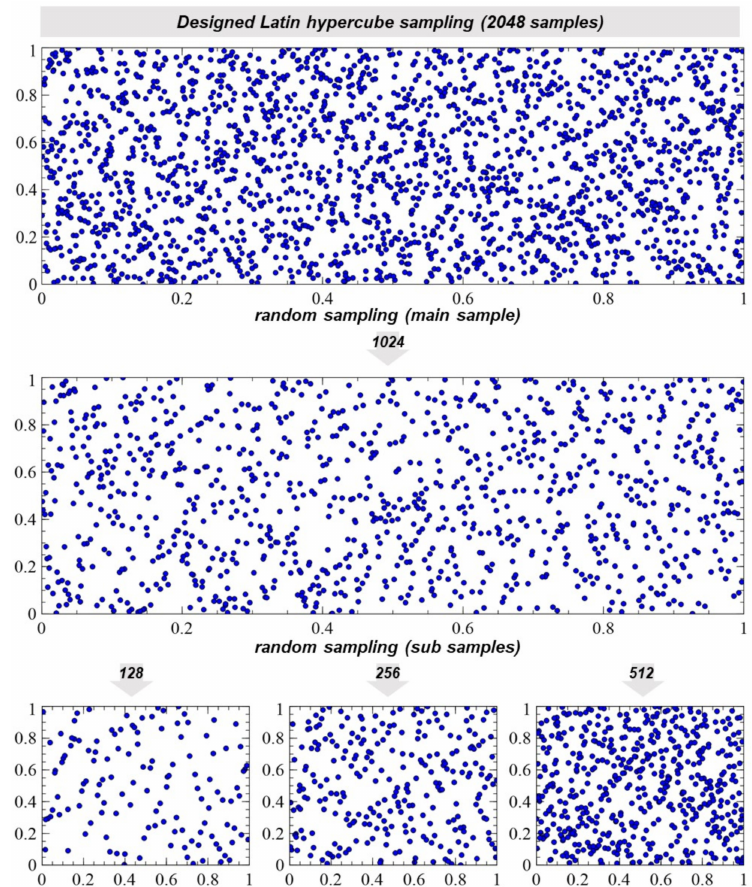
Figure 2. Random sampling of Latin hypercube sampled